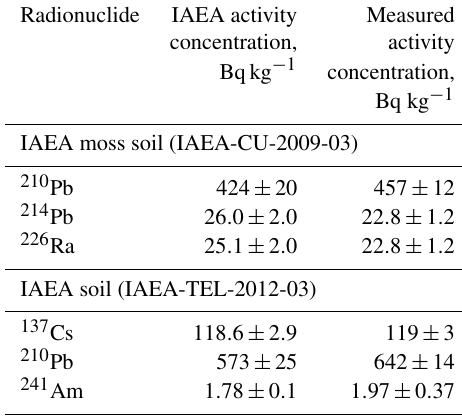
Table A1. Comparison of radionuclide activity concentrations ( ± counting error) in IAEA worldwide proficiency test soils compared with those measured in the laboratory during this study ( n = 3). The measured values are all within the acceptable IAEA statistical